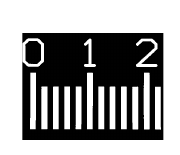
Fig. 3. Image segmentation